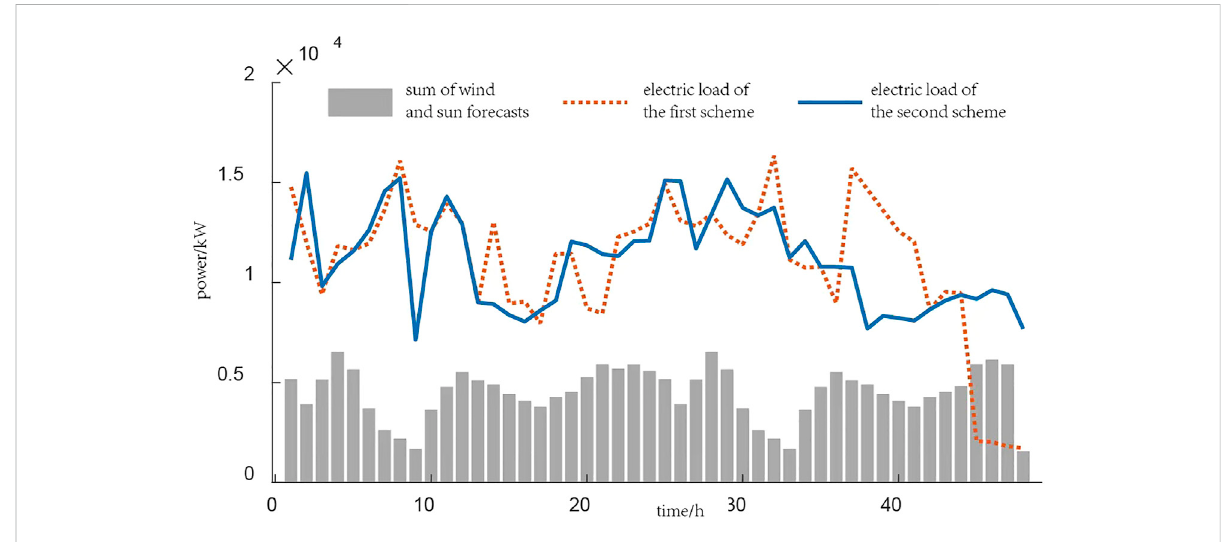
FIGURE 10 Comparison of renewable energy and load in two schemes.